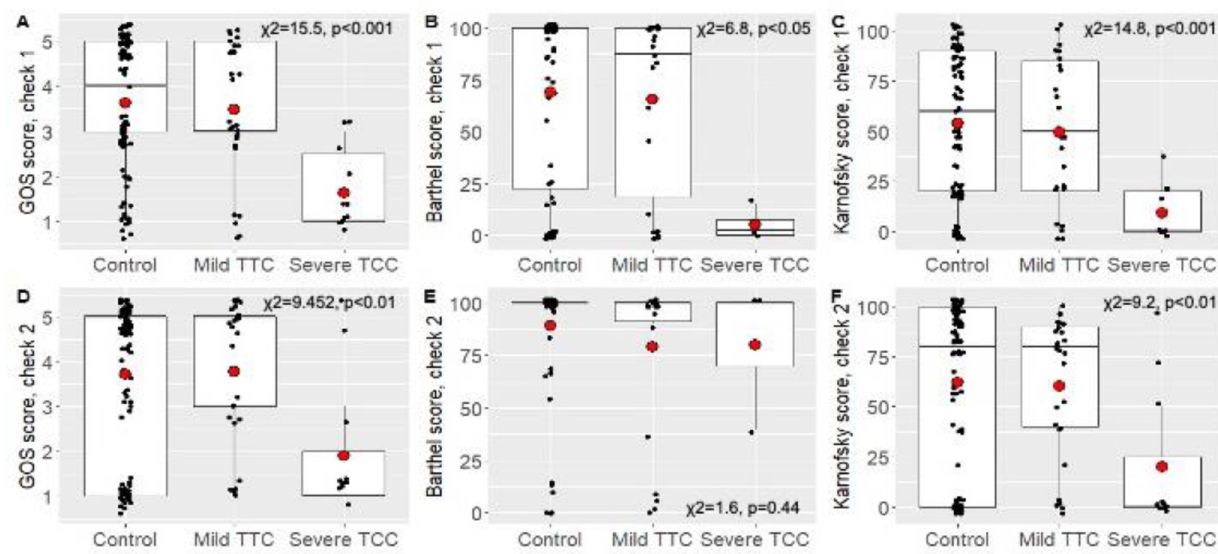
Fig 6. Differences in GOS, Barthel and Karnofsky scores between study groups at the first check-up at 30 days (A-) and the second check-up at 180 days (D-F). Boxplots show datapoints (black dots; jittered and outliers omitted for clarity), median, upper and lower quartiles, and minimum and maximum values; red dots indicate